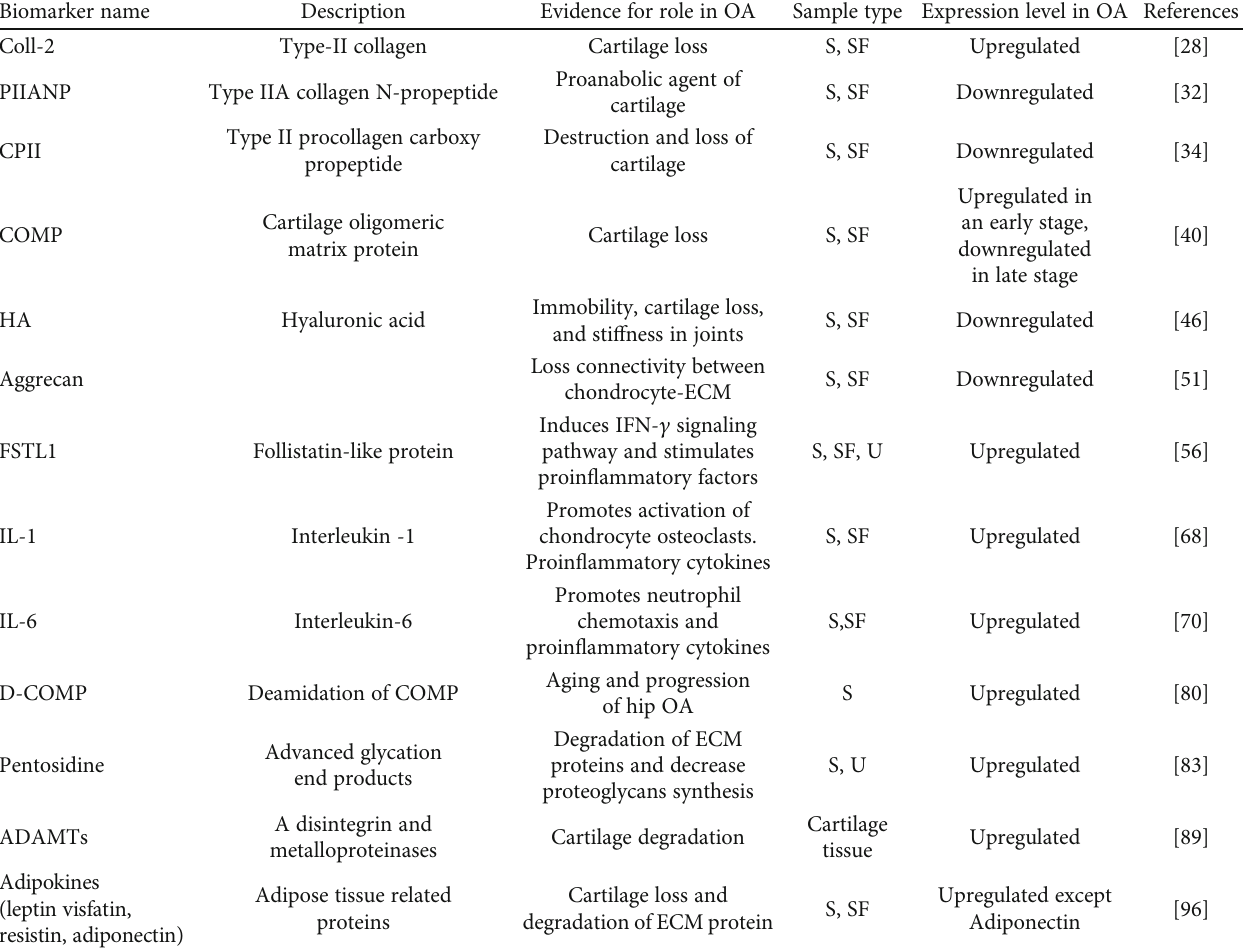
Table 2: List of biomarkers routinely used in the diagnosis and treatment of osteoarthritis and the studies of these markers in patients. Biomarker